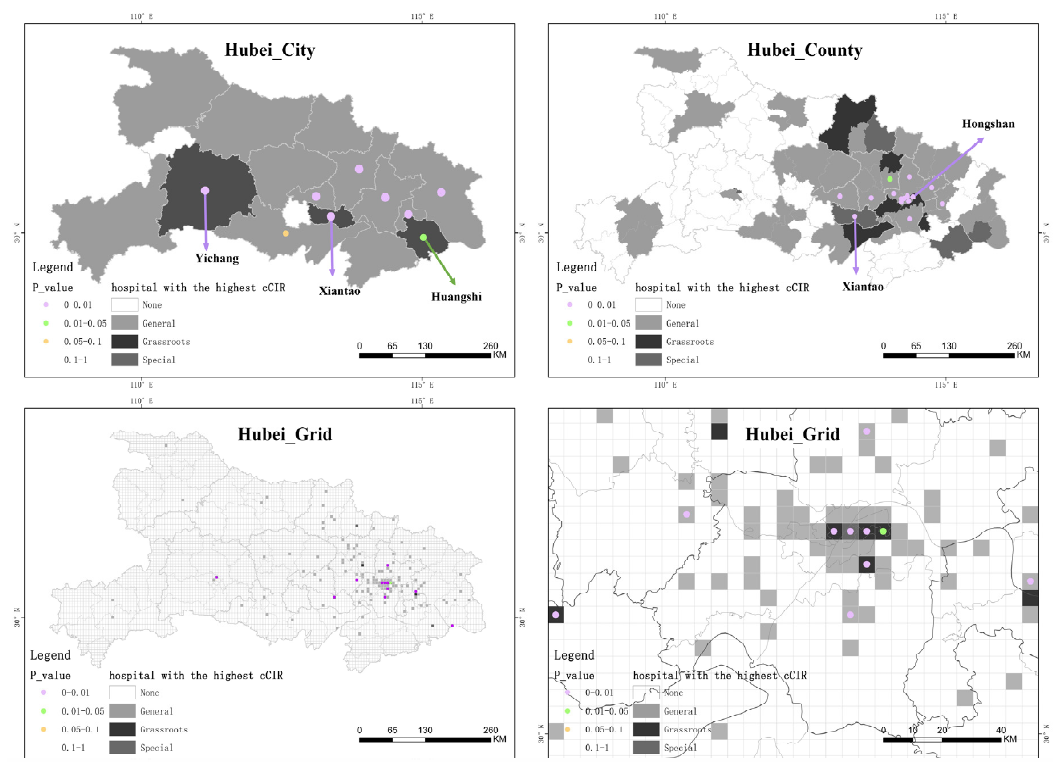
Figure 7. The hospital type with the highest infection rate and chi-square p -value